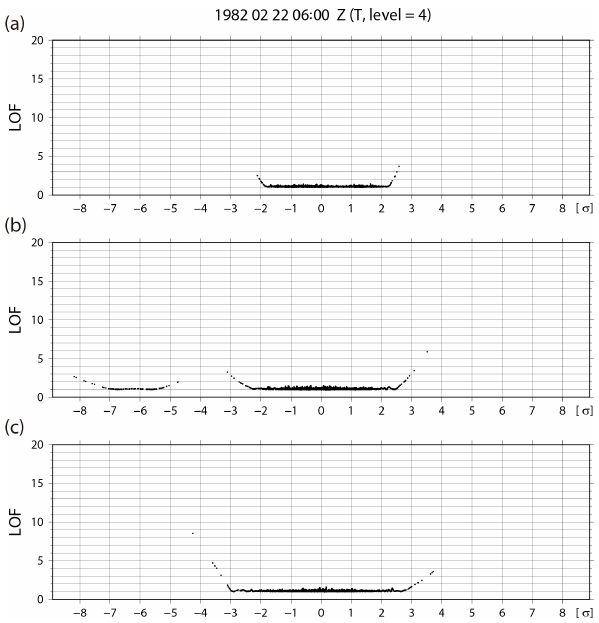
Figure 5. Scatter diagrams of the local outlier factor (LOF) method versus distance from the ensemble mean for all ensemble members for background temperature at the fourth model level ( ∼ 500hPa) at (a) grid point A (16.7 ◦ S, 90.0 ◦ E), (b) grid point B (35.3 ◦ N, 146.3 ◦ E), and (c) grid point C (35.3 ◦ N, 112.5 ◦